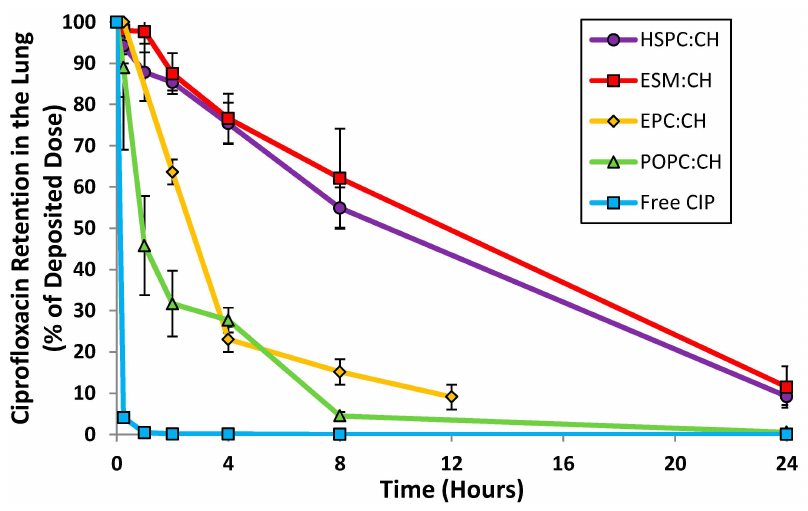
Figure 2. Retention of ciprofloxacin in the lung following intranasal instillation in mice (or inhalation for EPC:CH formulation). * CIP = Ciprofloxacin. CH = cholesterol. Adapted from [33,36,37].